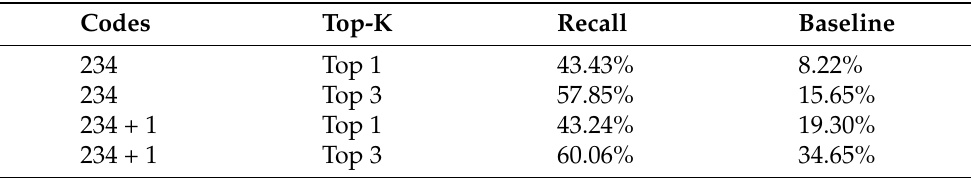
Table 10. Top-K results of 234 ICD codes.